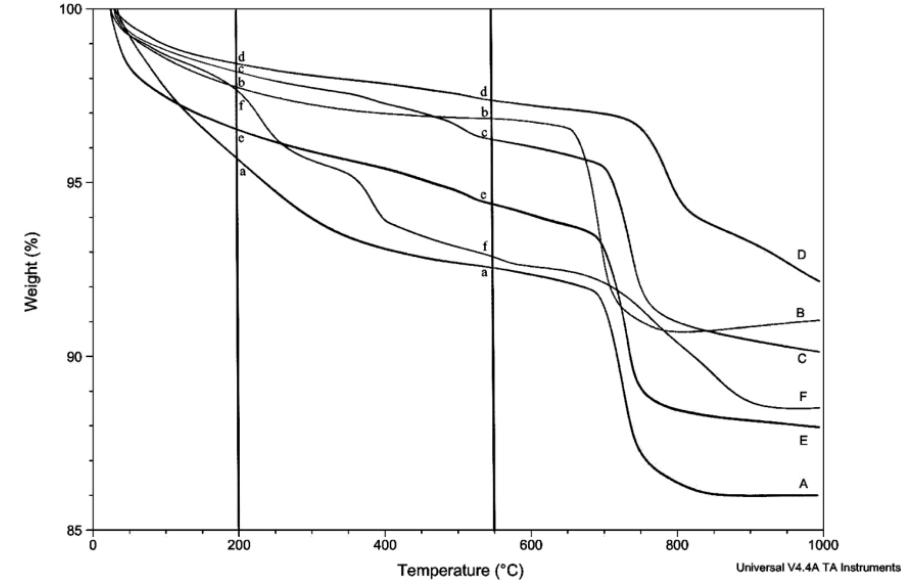
Figure 7. TGA scans for CCaApF sample containing 10.5 wt% carbonate after it had been processed under the following conditions: ( A ) the synthesized sample after in vacuo drying; ( B ) the sample after dehydration at 550 °C; ( C ) the dehydrated sample after immersion in water for 2 h at 22 °C; ( D ) the dehydrated sample after immersion in water for 4 days at 22 °C; ( E ) the dehydrated sample after immersion in water for 2 h at 100 °C; and ( F ) the dehydrated sample after immersion in water for 4 days at 100 °C. The decrease in weight from 200 °C to 550 °C is used to determine structural